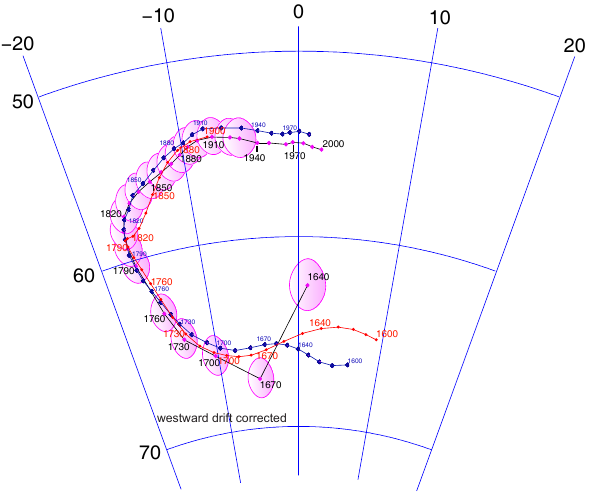
Fig. 7. Same figure and symbols as Fig. 3 but considering drift- corrected Italian data of Fig. 6. Equal area projection, lower emiphere of post-1640 mean Italian SV directions are calculated from data of Fig. 6 by means of a 9th polinomyal degree interpola- tion. Ellipses indicate 1D / 1I values of the mean drift-corrected Italian directions as listed in Table 1. Errors of data from the PM2009 model are